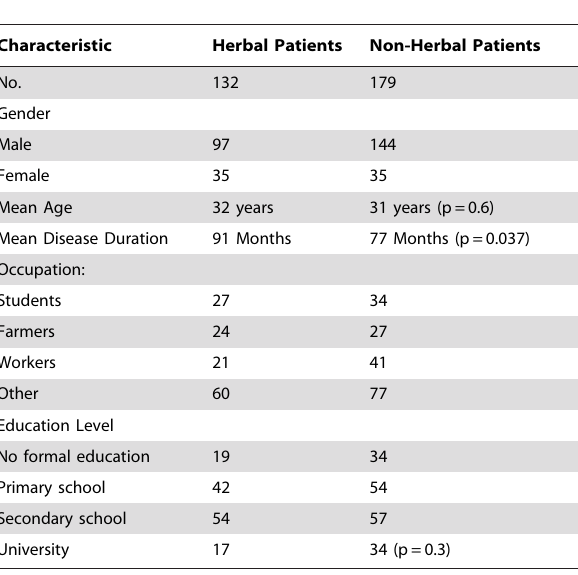
Table 1. The demographic characteristics of the study population.